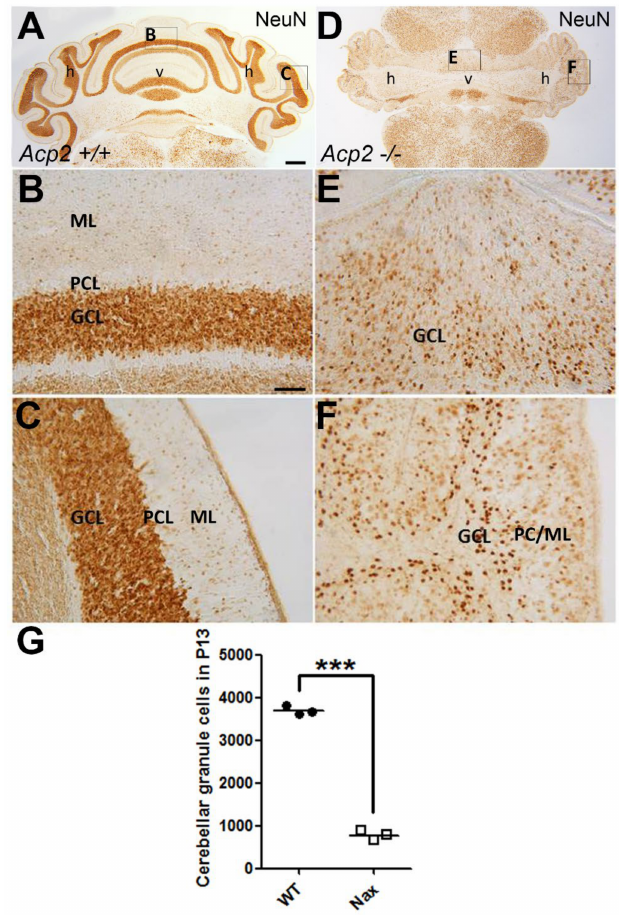
Figure 1. The number of cerebellar granule cells (GCs) is significantly decreased in nax compared to wt littermate mice. ( A – C ) Frontal section of P13 wt mouse cerebellum immunostained with neuro nuclei (NeuN) reveals a large number of mature GCs in the GC layer (GCL). The higher magnification shows medial ( B ) and lateral ( C ) views of the wt cerebellum ( A ). ( D – F ) Frontal section of P13 nax mouse cerebellum immunostained with NeuN shows that the cerebellum size is smaller and the lobules are underdeveloped. Evidently, the number of cerebellar GCs is much lower ( E , F ) than in the wt cerebellum (( B , C ) for direct comparison). The higher magnification shows medial ( E ) and lateral ( F ) views of nax cerebellum ( D ). ( G ) Cell counting of the frontal sections of P13 samples shows a significant difference in the number of GCs between wt and nax cerebella ( G ). The graph represents the average cell counts at P13 in sections from wt and nax littermates (wt; n = 3 and nax ; n = 3) and shows that the number of GCs amounts to only ~20% of that scored in wt cerebella. The data in the graph are presented as the mean ± SEM. Statistical analysis was performed using unpaired t -test (*** p < 0.001). Abbreviations: GCL, GC layer; PCL, PC layer; ML, Molecular layer; h, hemisphere; v, vermis. Scale bars: 500 µ m in ( A ) applies to ( A , D ), and 100 µ m in ( B ) applies to ( B , C , E , F